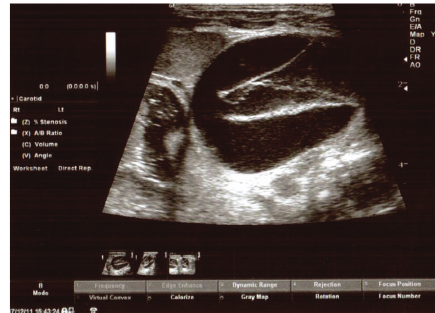
Figure 2: Postnatal ultrasonographic appearance with marked septations.